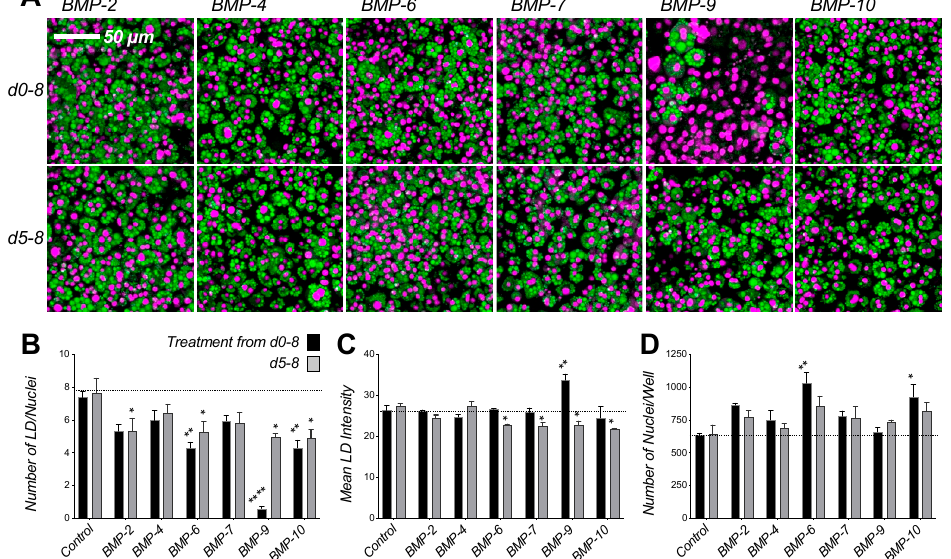
Figure 2. BMP-ligands induce 3T3-L1 proliferation. ( A ) 3T3-L1 cells were grown with 1 nM ligand as noted or vehicle control (PBS) from day 0 (top panel) or day 5 (bottom panel) of differentiation until day 8. Vehicle control is shown in Figure 1B. Cells were fixed at day 8 and stained for lipids using Nile red (green), nuclei were counter-stained with DAPI (magenta). Cells treated with various BMPs generally show increased number of nuclei and DAPI fluorescence. ( B – D ) Quantitative analysis of 3T3-L1 samples treated with ligands from day 0 (black) or day 5 (grey) of differentiation. Confocal images were analyzed using ImageJ and data were evaluated using Prism 9. Statistical significance from two biological replicates was calculated by two-way ANOVA and Dunnett’s multiple comparisons test (* p < 0.05; ** p < 0.01; **** p < 0.0001). ( B ) Total number of lipid droplets (LD) per well. ( C ) Mean lipid droplet intensity. ( D ) Number of nuclei per well.